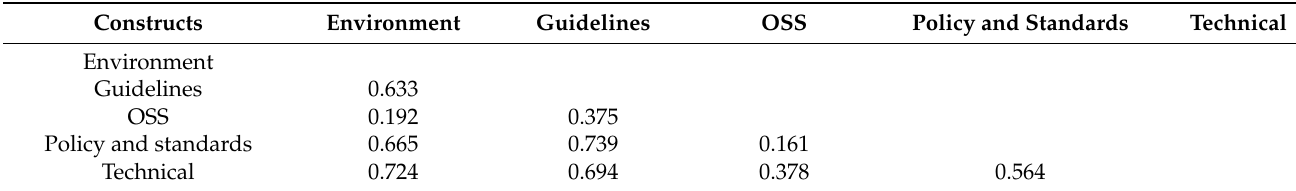
Table 5. Discriminant validity (HTMT).